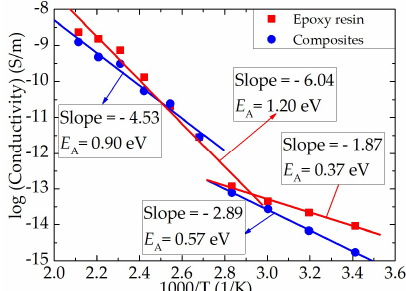
Figure 7. Conduction current of epoxy resin ( a ) and epoxy/nano−SiO 2 /micro−BN composite ( b ) as a function of time.